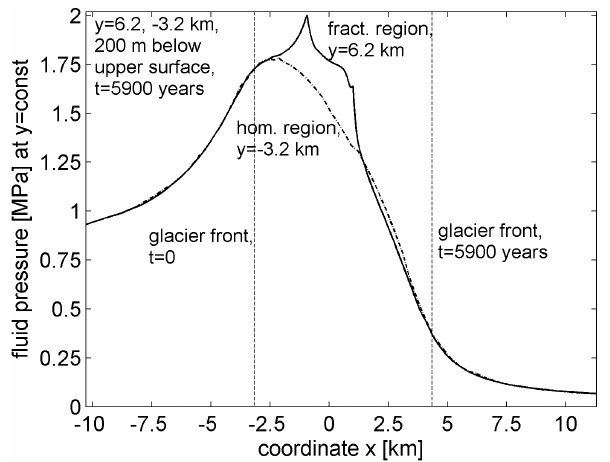
Figure 7. Variation of fluid pressure [Pa] in the cross sections of the fractured and homogeneous regions of the rock; y = 6200 and − 3200m, respectively, at a depth of 200m and at time 5900 years. The rock is subjected to spatially non-uniform fluid pressure and compressive stress.